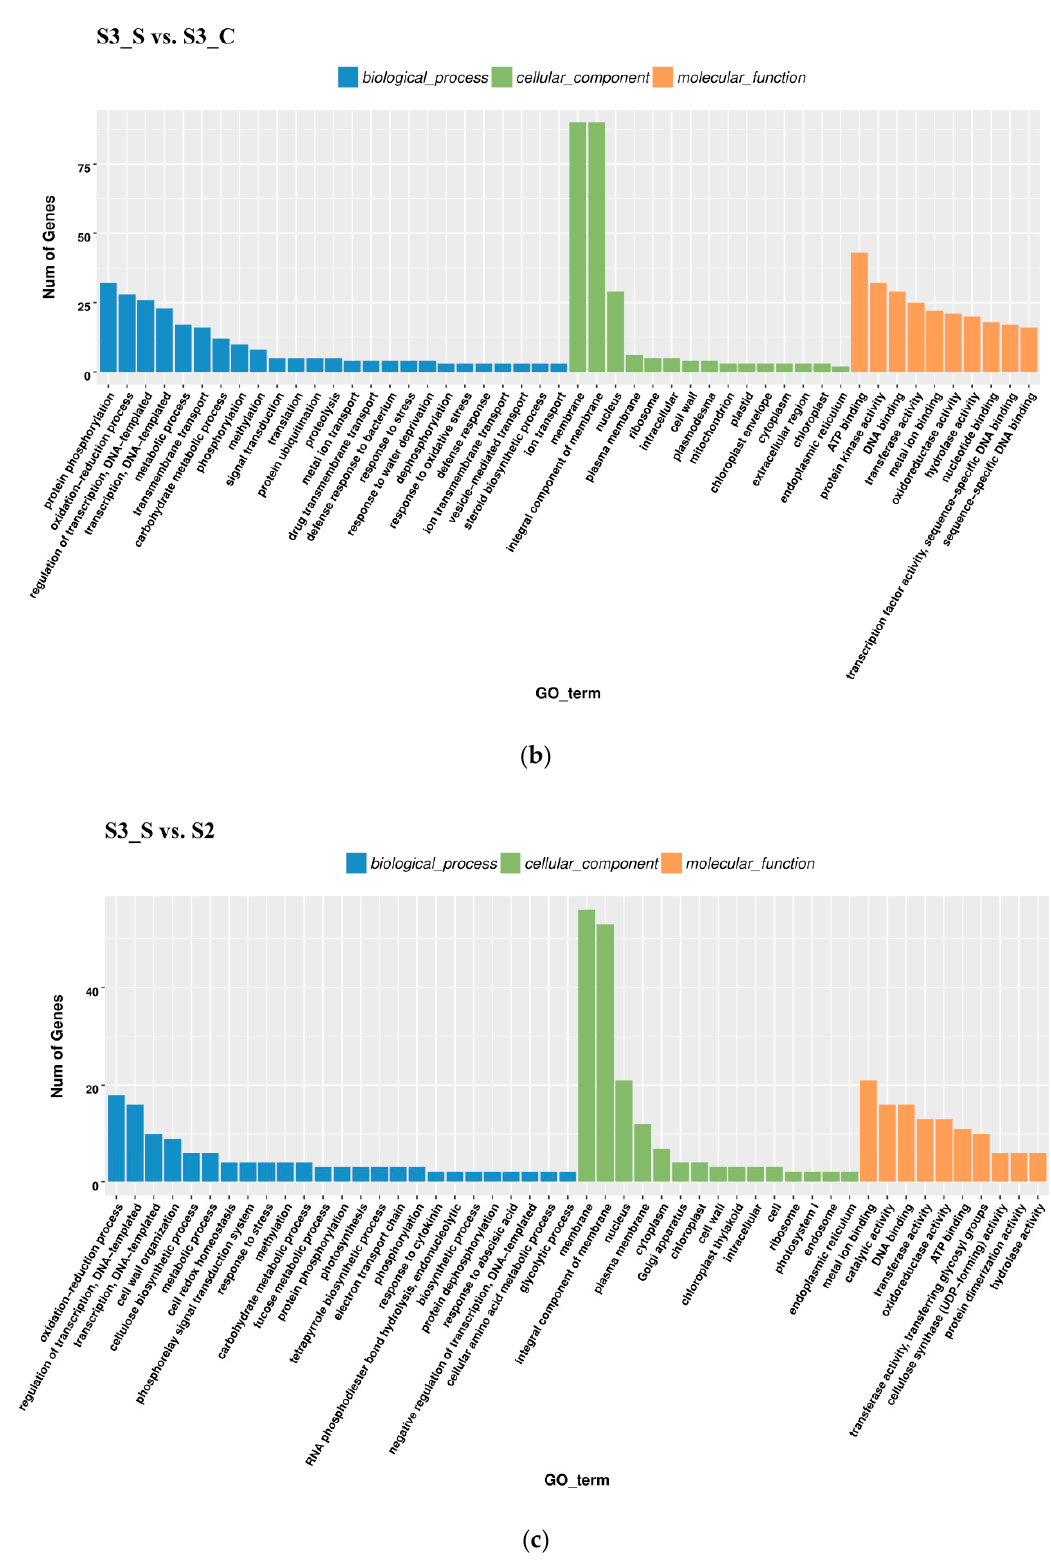
Figure 5. Gene Ontology (GO) enrichment analysis in pairwise comparisons. ( a ) GO enrichment analysis in S2 vs. S1. ( b ) GO enrichment analysis in S3_S vs. S3_C. ( c ) GO enrichment analysis in S3_S vs. S2.